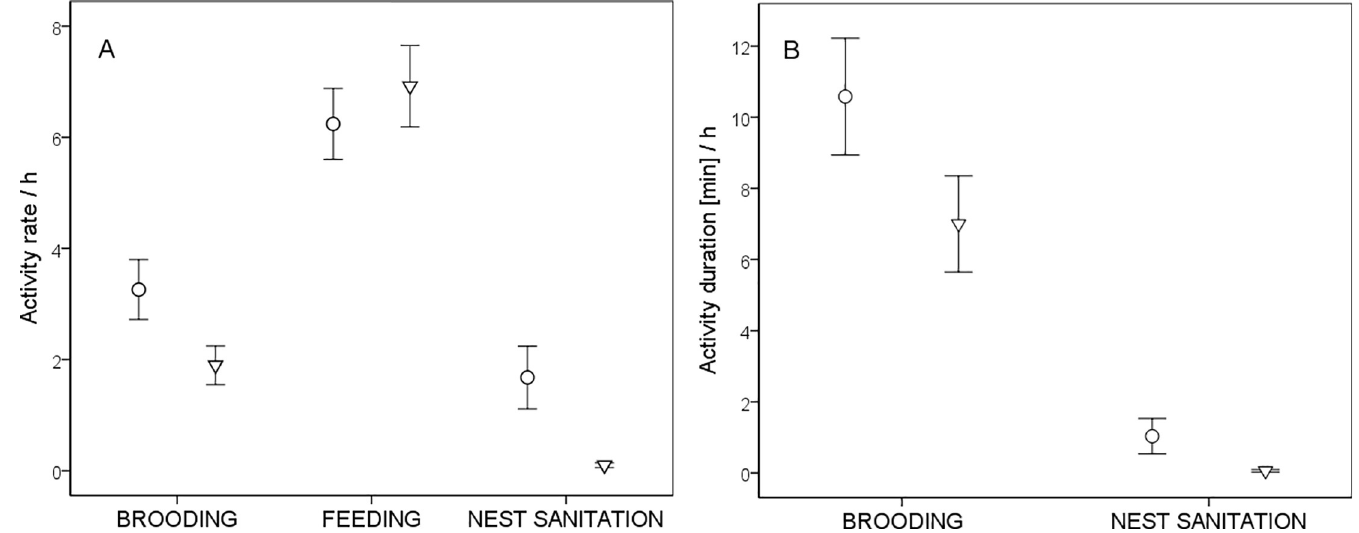
Fig 1. Blackcap male ( ▼ ) and female ( ● ) parental investment during 1 hour observation, n = 50 nests. A–activity rate/h, B–activity duration/h. Bars show ± 1SE.